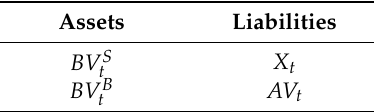
Table 3. Balance sheet at time t